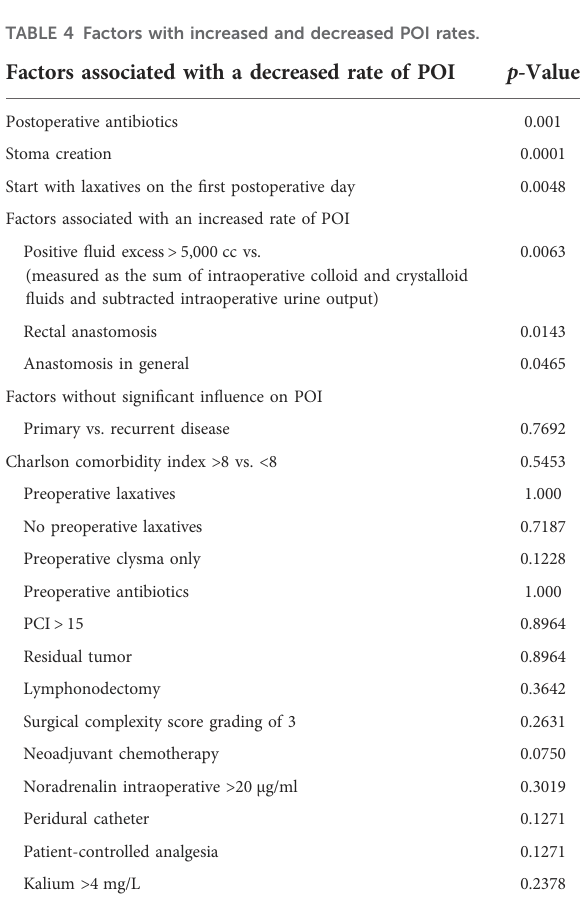
Interaction between anastomoses and POI